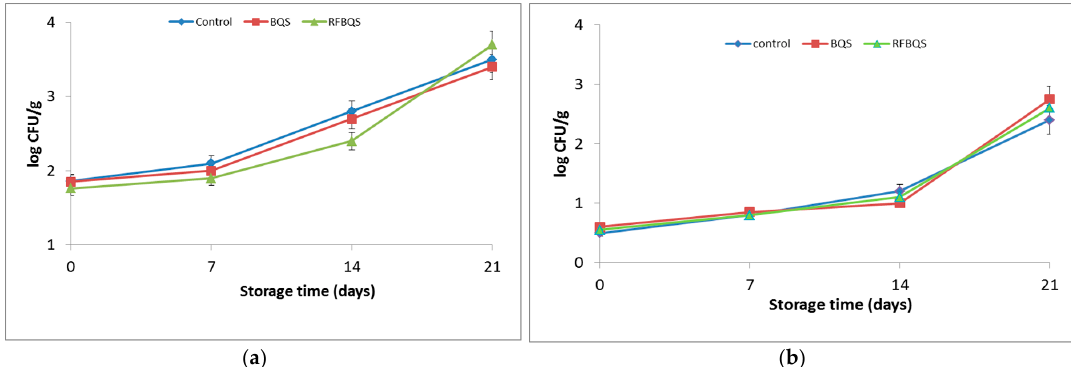
Figure 2. Microorganism, ( a ) mesophilic aerobic bacteria; ( b ) lactic acid bacteria, counts (log colony forming units (CFU)/g) of Bologna-type sausages (control, sausage with black quinoa seeds (BQS), and sausage with its fibre-rich fraction (RFBQS)) during cold storage.